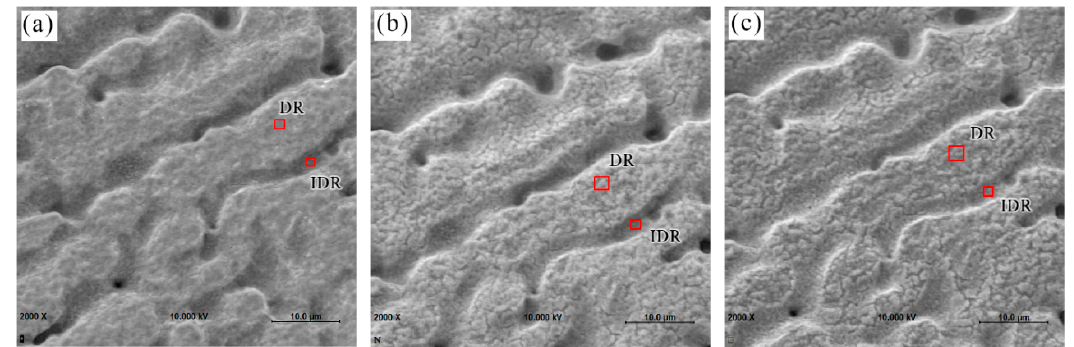
Figure 9. ( a ) SEM morphology of a 180 s formed TCC on Zn55Al and ( b ) 2D-EDS elemental maps of Al, Zn, Zr, Cr, F, Si, C and O performed over the area on the specimen marked with red dotted rectangle as indicated in Figure 9a.